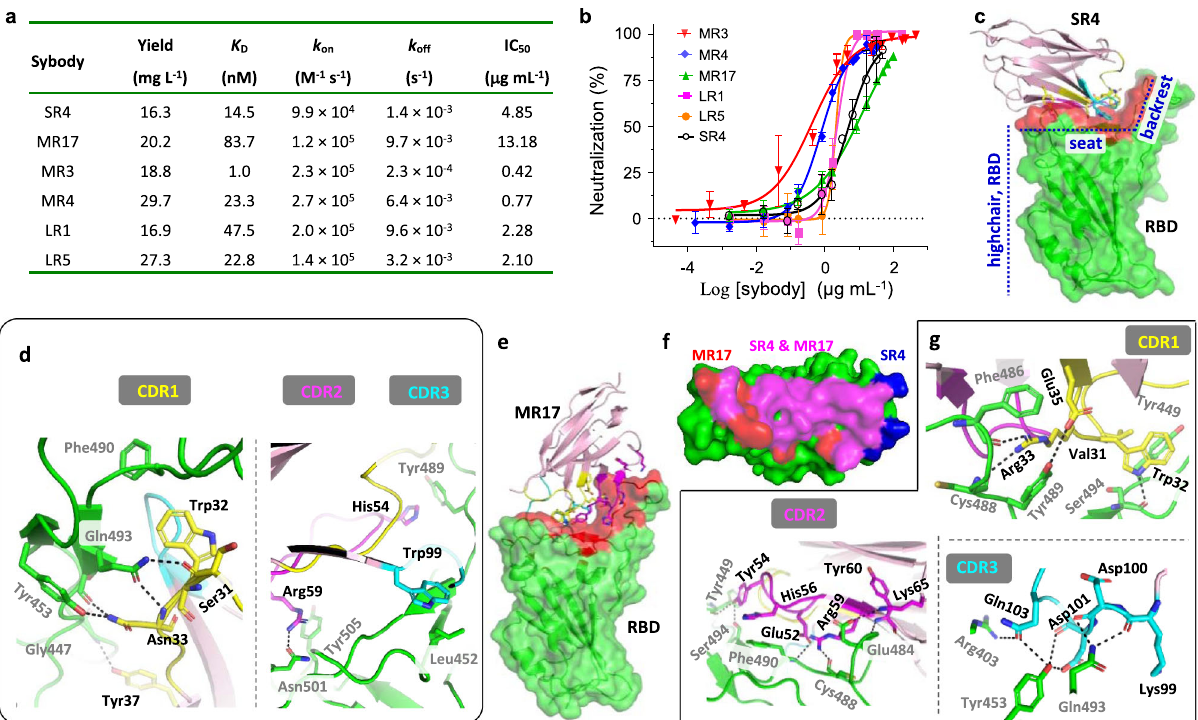
Fig. 1 Biochemical and structural characterization of neutralizing synthetic nanobodies (sybodies). a Summary of the characterization. Yield refers to puri fi cation from 1 L of culture. b Neutralization assay. SARS-CoV-2 pseudoviruses were preincubated with different concentrations of sybodies before infection of VeroE6-hACE2 cells. The rate of infection was measured by FACS. IC 50 was obtained by Sigmoidal fi tting of the percentage of neutralization. Mean± standard deviation are plotted ( n = 3 or 4 independent experiments). Error bars are omitted where, in rare cases, available data points are less than three due to experimental design on concentration replicates. Color coding of the sybodies is as indicated. c The overall structure of SR4 (pink cartoon) in complex with RBD (green surface), which resembles a short backrest high chair. The binding surface is highlighted red. d SR4 CDR1 (yellow), CDR2 (magenta), and CDR3 (cyan) all contribute to the binding. Note that Tyr37 is a framework residue. e The overall structure of the MR17 (pink cartoon) in complex with RBD (green surface). The binding surface is highlighted red. f The overlap (magenta) between the SR4 (blue) and MR17 (red) interacting surfaces on RBD. g All three CDRs contribute to the binding with the receptor-binding domain (RBD) (green). Lys65 and Tyr60 are from the framework region. CDRs are color-coded as indicated in d . Dashed lines indicate H-bonding or salt bridges between atoms that are <4.0 Å apart. Black texts label sybody residues and gray texts label RBD residues. Source data for b are provided as a Source data fi le. CDR complementarity determining region, FACS fl uorescence-activated cell sorting, RBD receptor-binding